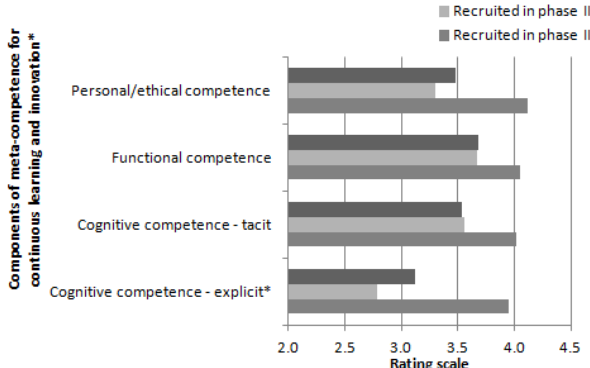
Fig. 12. Perception of components of the meta-competence for con- tinuous learning and innovation perceived to be acquired from inter- national post-graduate education and local post-graduate education, in phase I (1970–1987), II (1987–1998) and III (1998–present); rat- ing scale from 1 to 5, where 1=not at all, 3=to some extent, and